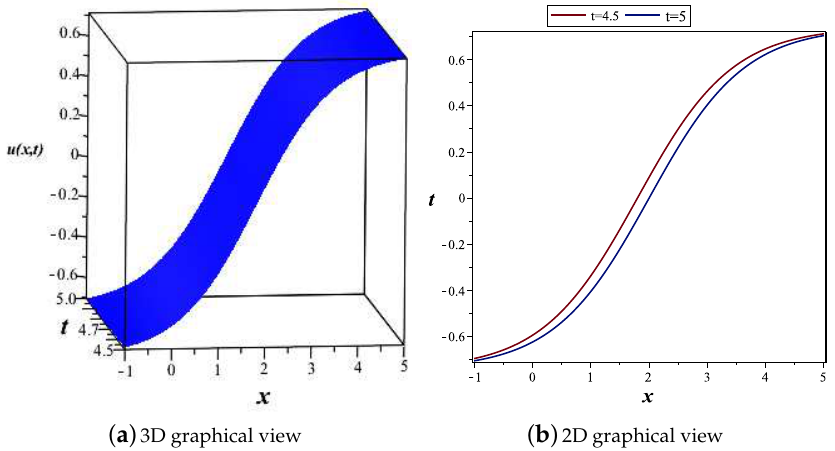
Figure 4. Graphical representation of Equation (36) within interval − 1 ≤ x ≤ 5 and 4.5 ≤ t ≤ 5 (( a ) 3D plot, ( b ) 2D plot for t = 4.5,